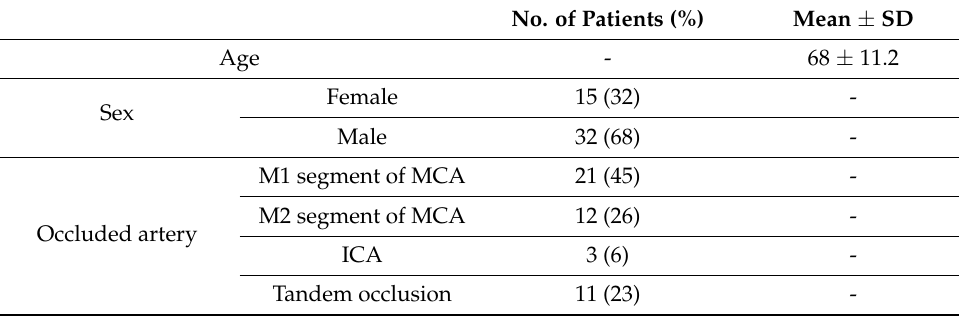
Table 3. Relevant initial clinical, imaging, and stroke treatment